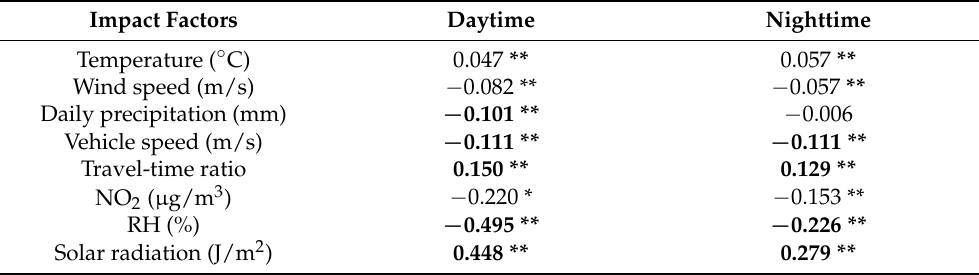
Table 2. Results of stepwise regression model between O 3 concentration and various factors. Model Temperature ( ◦